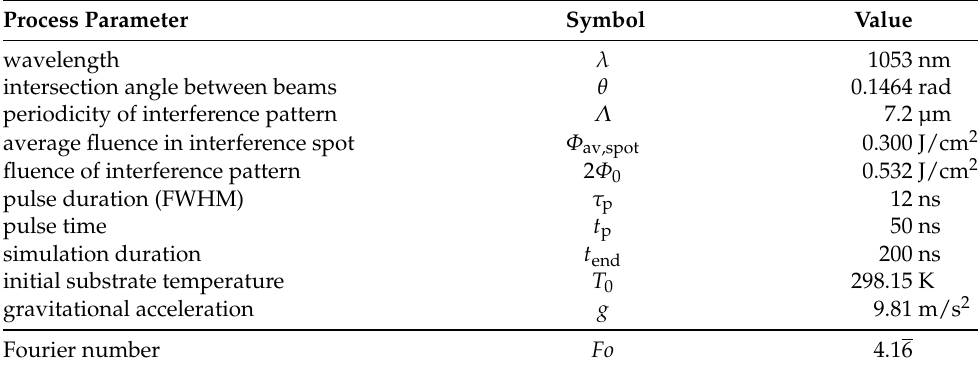
Table 1. Process parameters of single pulse DLIP on stainless steel with sulphur